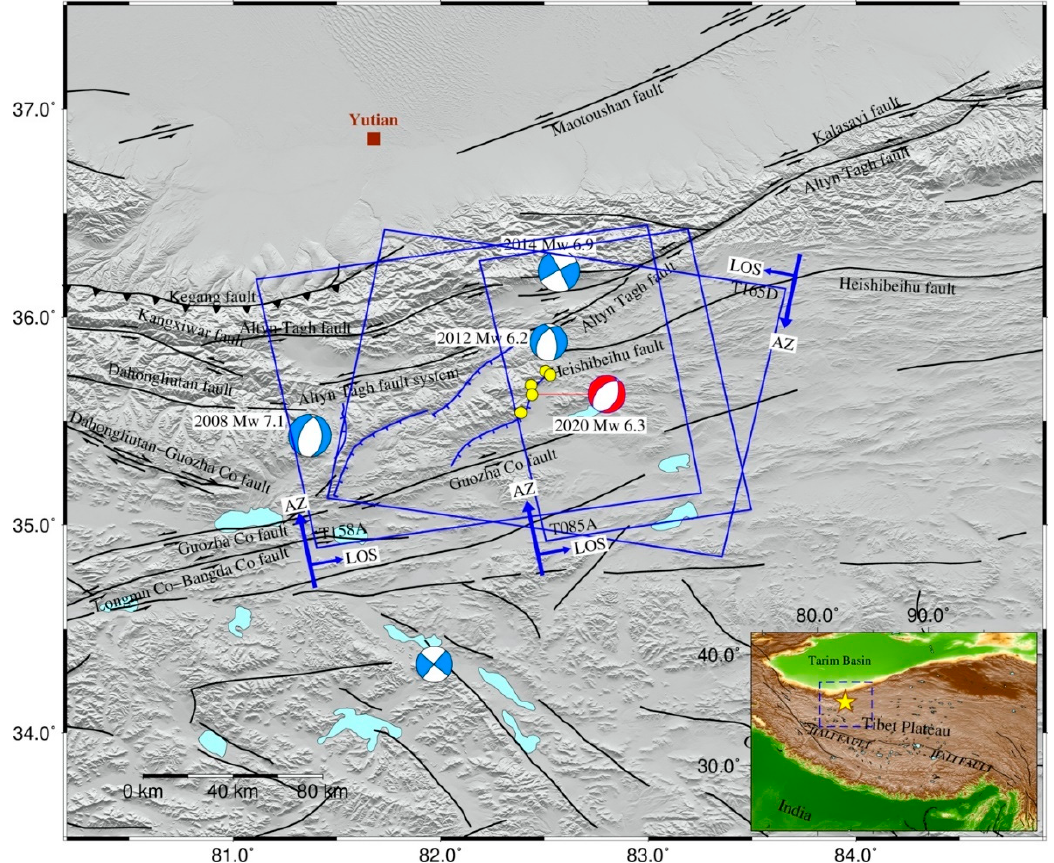
Figure 1. Topographic and tectonic setting map surrounding the 2020 Mw 6.2 Yutian earthquake. Beach balls represent focal mechanism solutions of events with magnitude larger than Mw 6 during 1976–2020 from the Global Centroid-Moment-Tensor (GCMT), light blue represents historical events and red the 2020 event. Yellow points are aftershocks (M ≥ 4) within one week after the main shock from the US Geological Survey (USGS). Blue and black lines indicate regional active faults from [12,13], respectively. Blue rectangles depict footprints of Sentinel-1 A/B images used in this study. The insert map shows the location of the epicenter and the study region in Tibet Plateau. The yellow star is the epicenter, and the dashed blue rectangle is our study region.